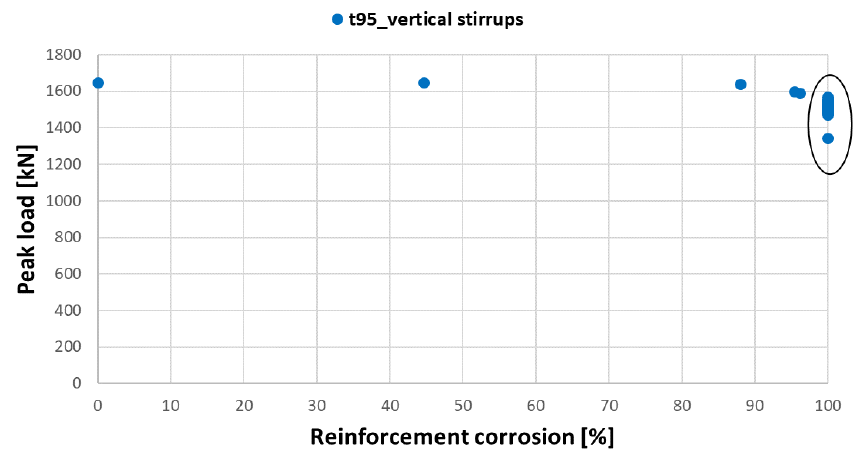
Figure 23. Correlation between peak load and vertical stirrups corrosion (t95).